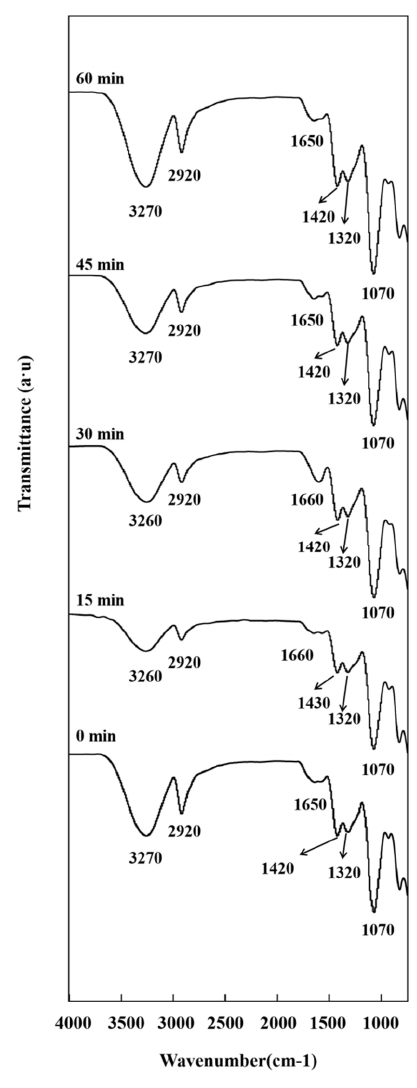
Figure 4. FTIR spectra of PVA/CMC/ZnO NPs/ x GnP (ZnO NPs: x GnP = 5:5) composite films under different ultrasonication times.